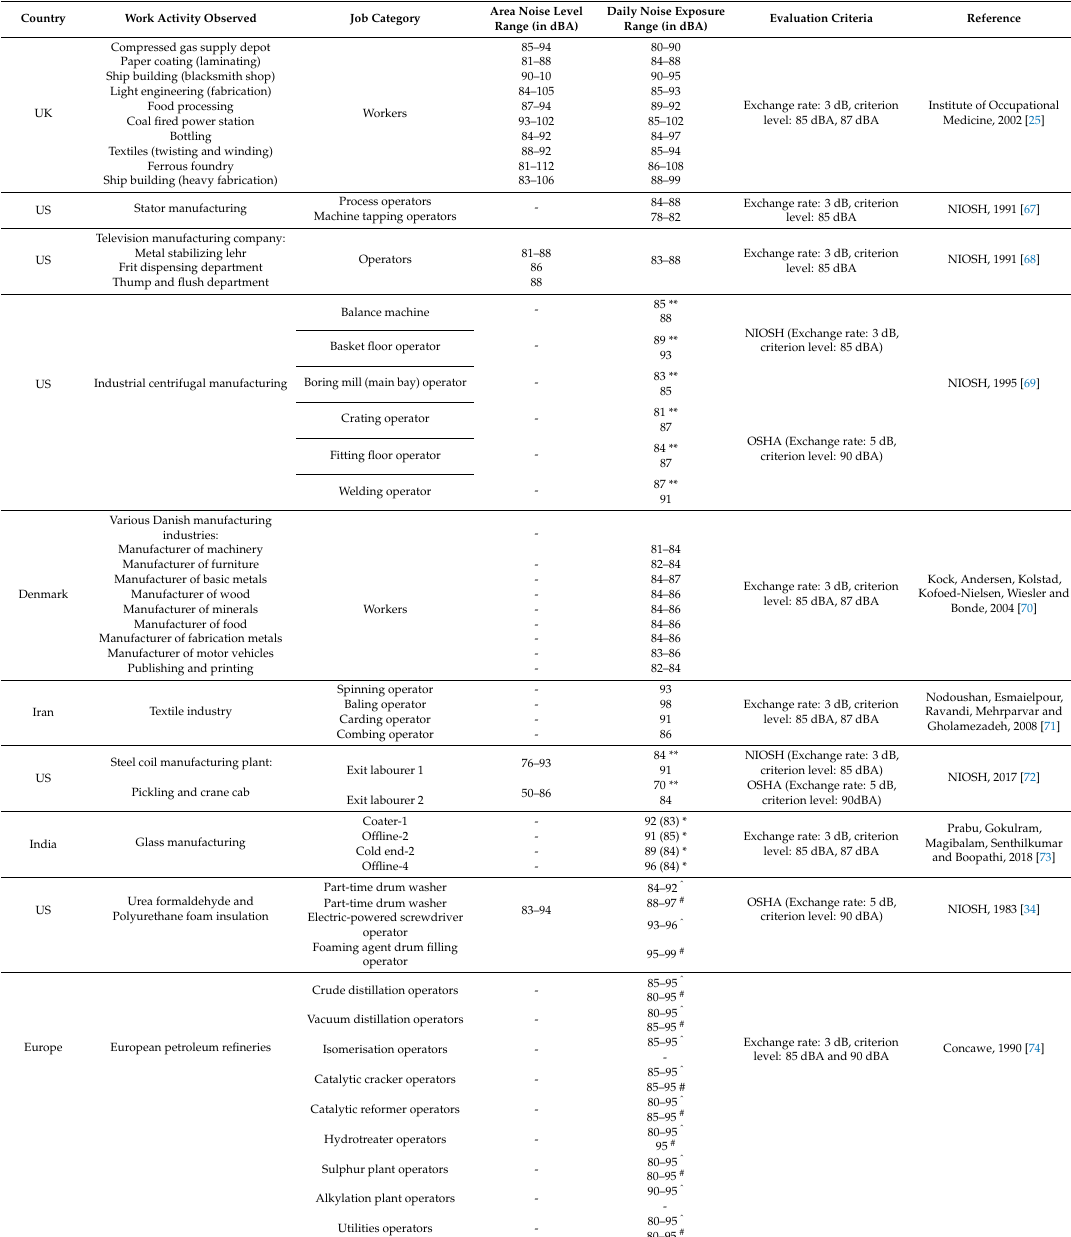
Table 4. Correlation between activity-based area noise levels and employee daily noise dose.